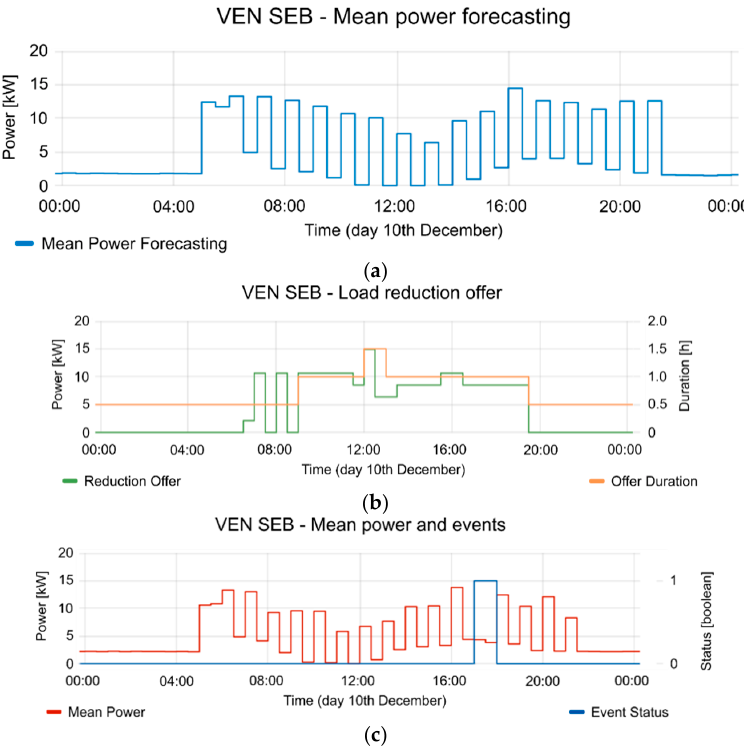
Figure 20. Detailed information from 10 December event. ( a ) mean power forecasting; ( b ) reduction offer and offer duration; ( c ) mean power and event status (where 1 is active and 0 is inactive).